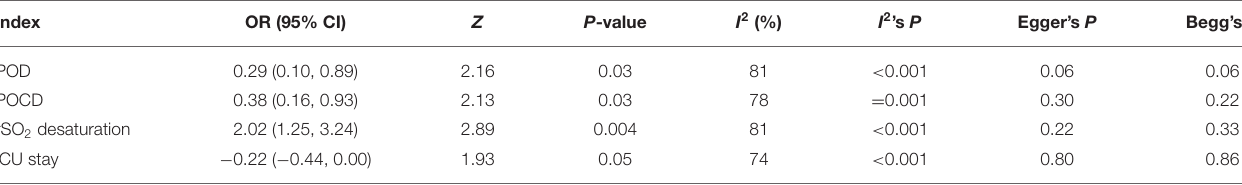
TABLE 4 | Evaluation of publication bias and sensitivity